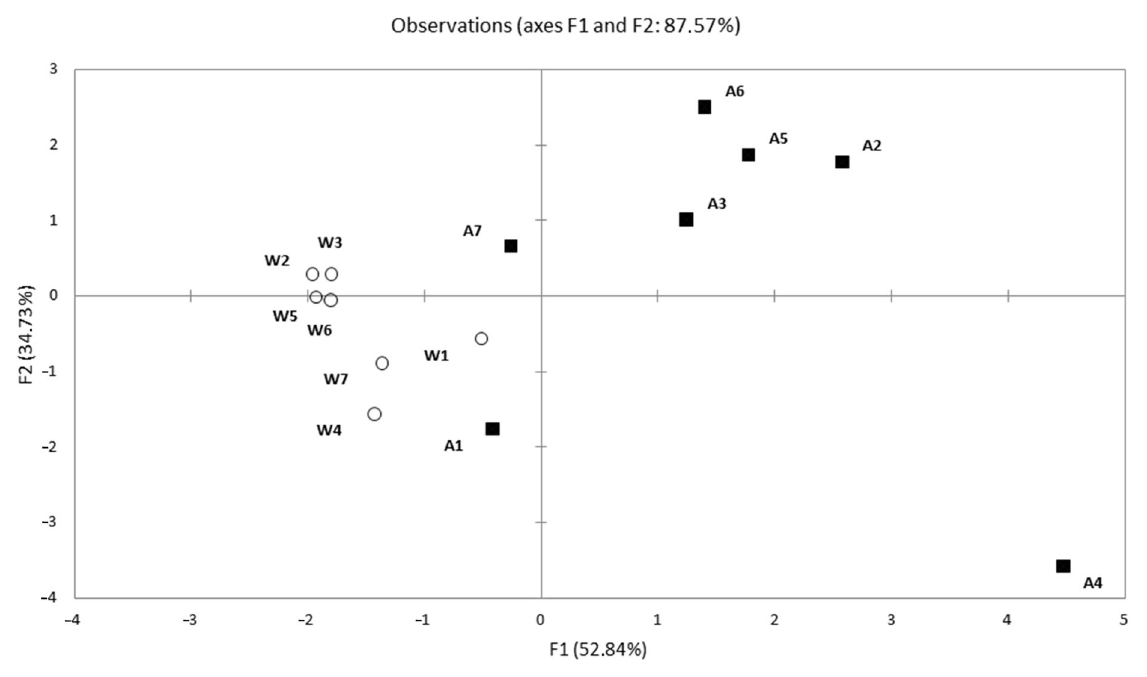
Fig. 3. Results of principal component analysis showing investigated concentrations of heavy metals during winter (W) and autumn (A)